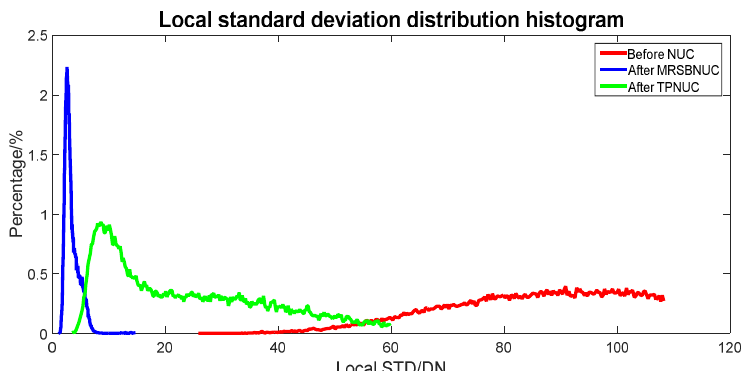
Figure 11. Local standard deviation distribution of clear sky scene: before NUC, after TPNUC, and after MRSBNUC.